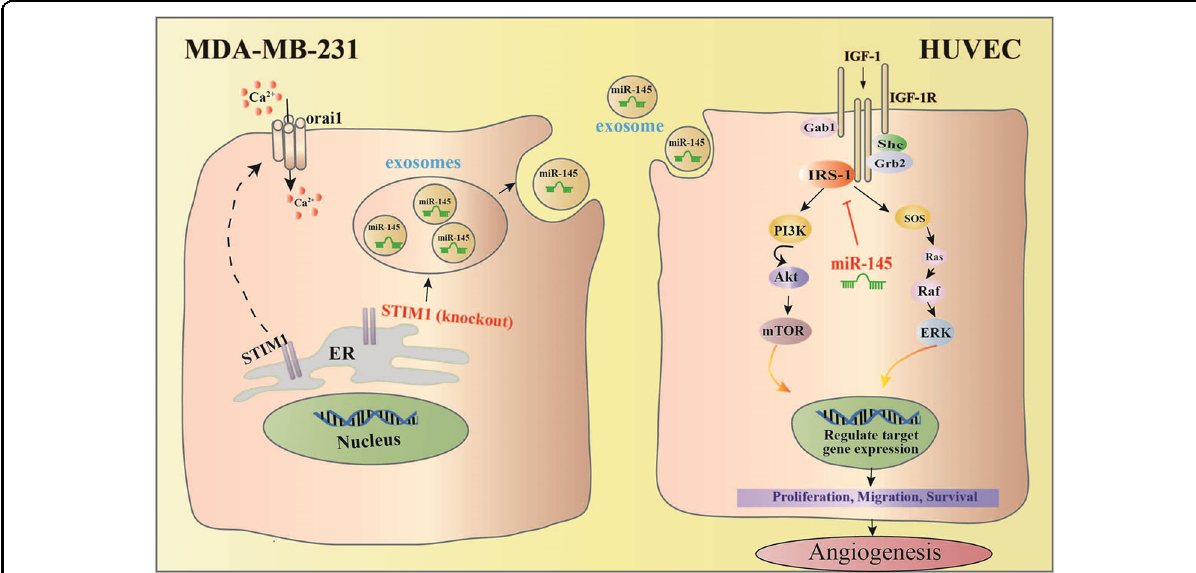
Fig. 7 Exosomes from STIM1-KO-MDA-MB-231 breast cancer cells contain higher levels of miR-145, which targets IRS1 and its downstream signal to suppress tube formation of vascular endothelial cells, resulting in anti-angiogenesis effect. Predicted anti-angiogenic mechanism of exosomal miR-145 from STIM1-KO-MDA-MB-231 cells via targeting